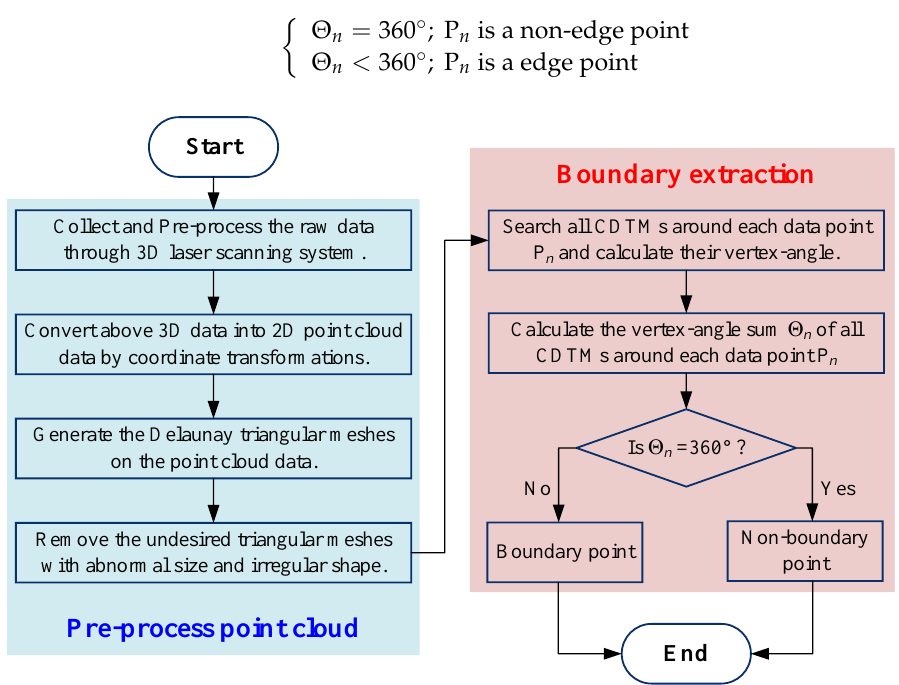
Figure 4. The flowchart of the developed CDTM-based boundary extraction method.